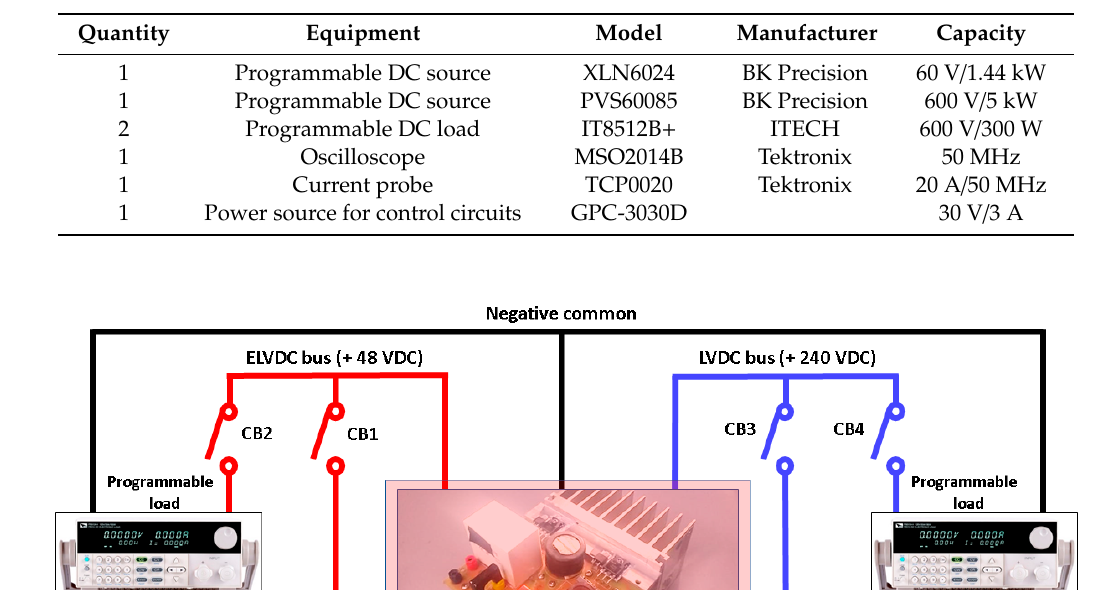
Table 3. Equipment used in the experimental setup.